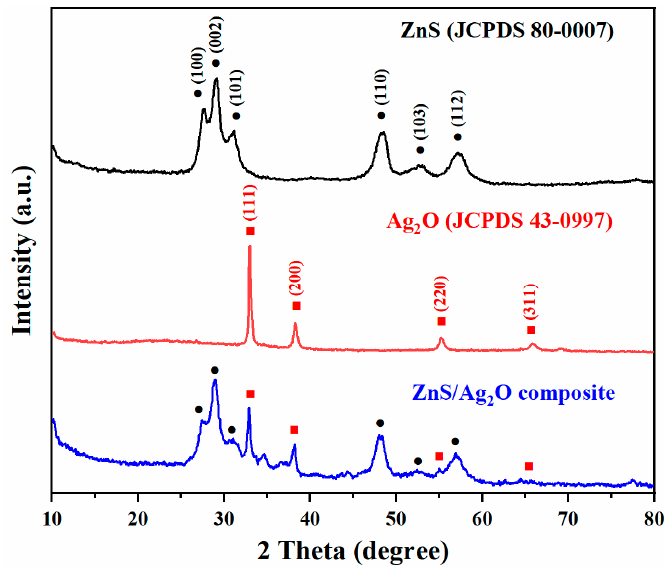
Figure 1. XRD patterns of the as-prepared ZnS, Ag 2 O, and ZnS/Ag 2 O composite. Standard XRD peaks of ZnS (JCPDS 80-0007) and Ag 2 O (JCPDS 43-0997) are marked.